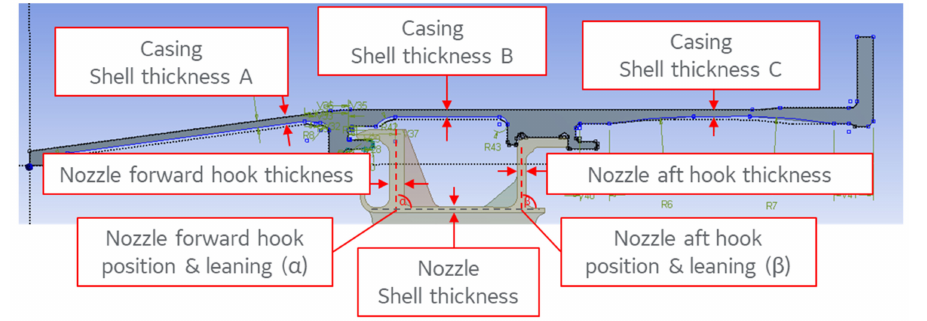
Figure 12. Geometrical parameters dedicated for